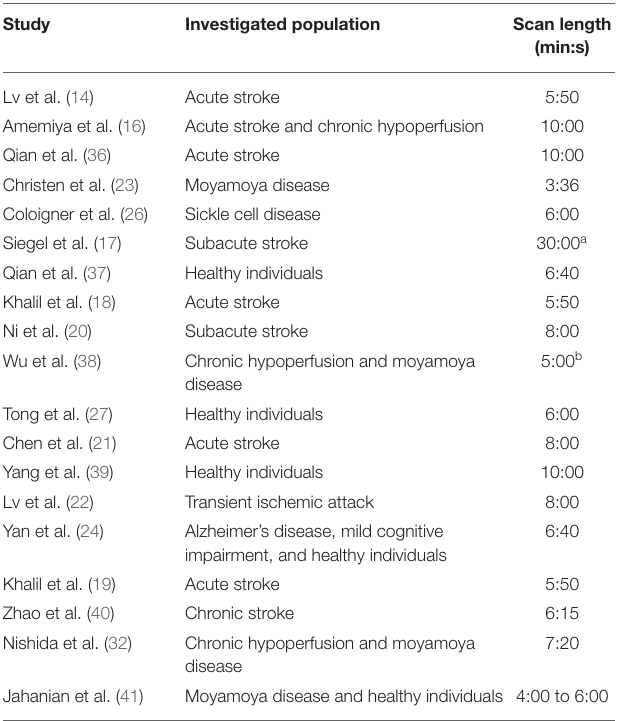
TABLE 1 | Overview of resting-state functional MRI scan lengths used in previous studies on BOLD delay for the assessment of brain perfusion. Study Investigated